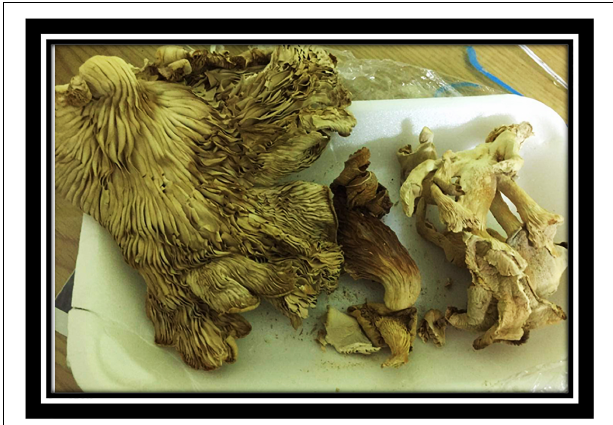
FIGURE 1 | Fruiting bodies of Pleurotus ostreatus